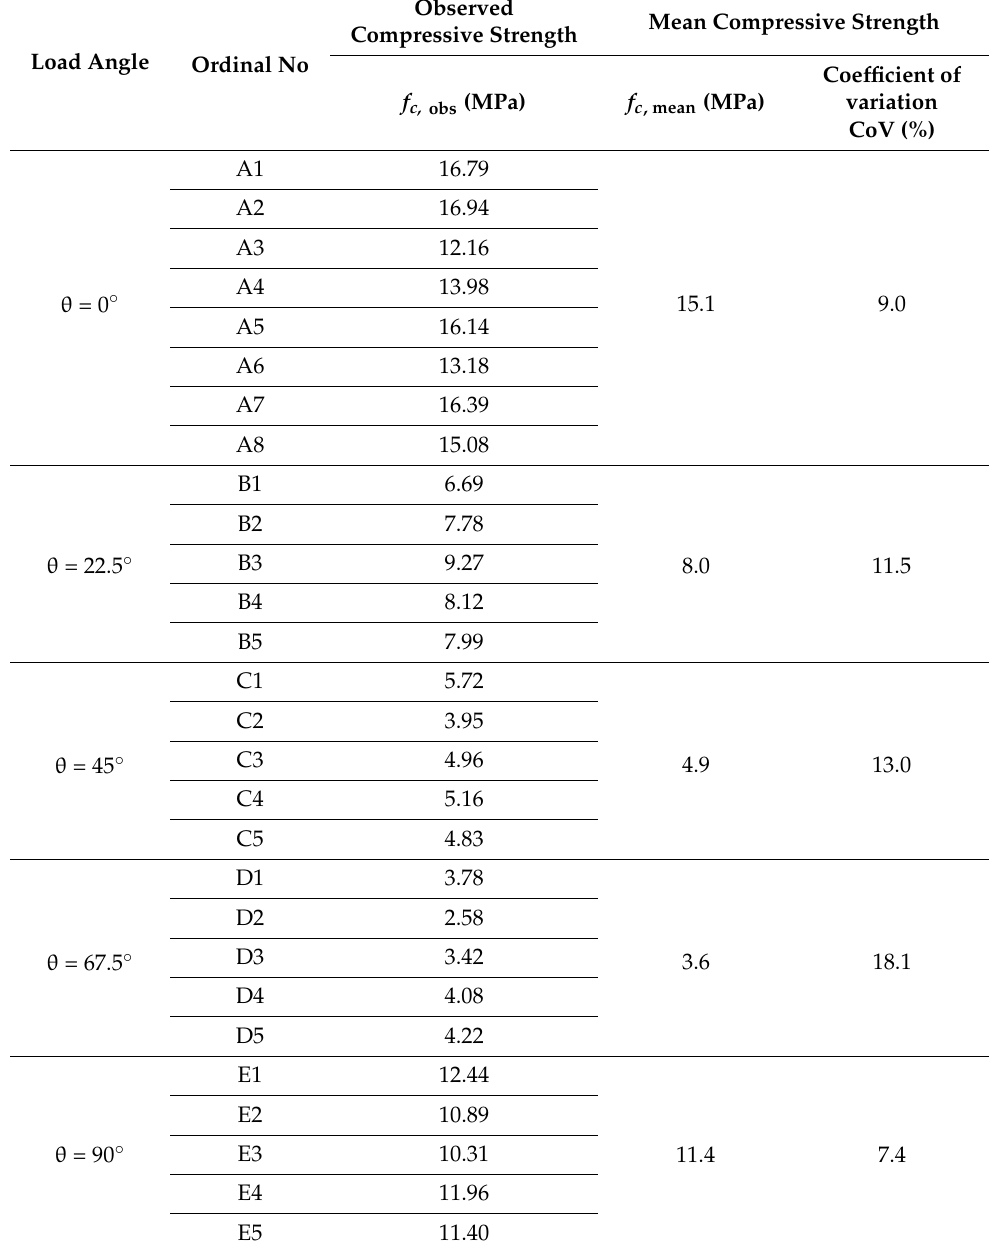
Table 2. Compressive strength testing results of wall samples with different angles of bed joints θ